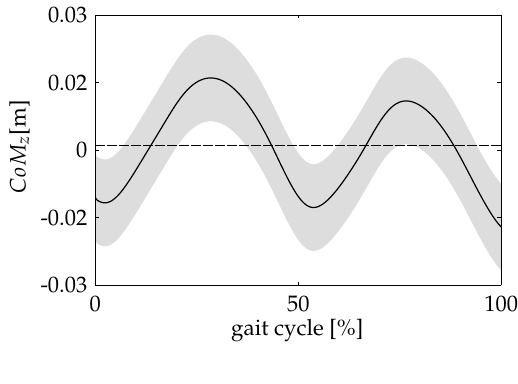
Figure 3. The CoM vertical excursion (mean ± SD) of the non-amputee group.